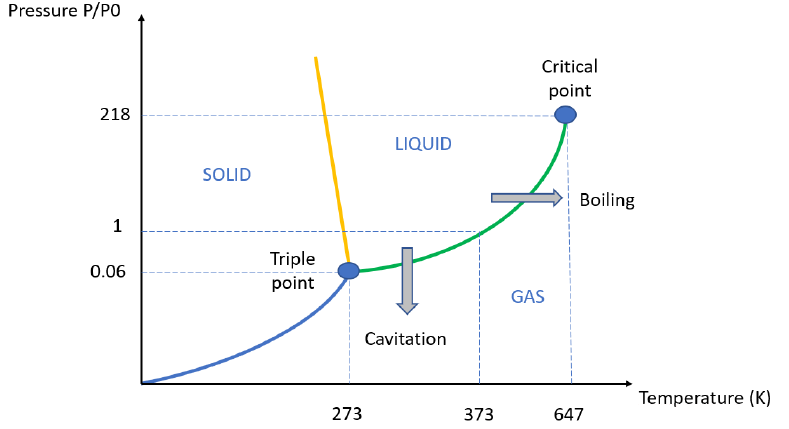
Figure 2. Water phase diagram, P0 = 10,1325